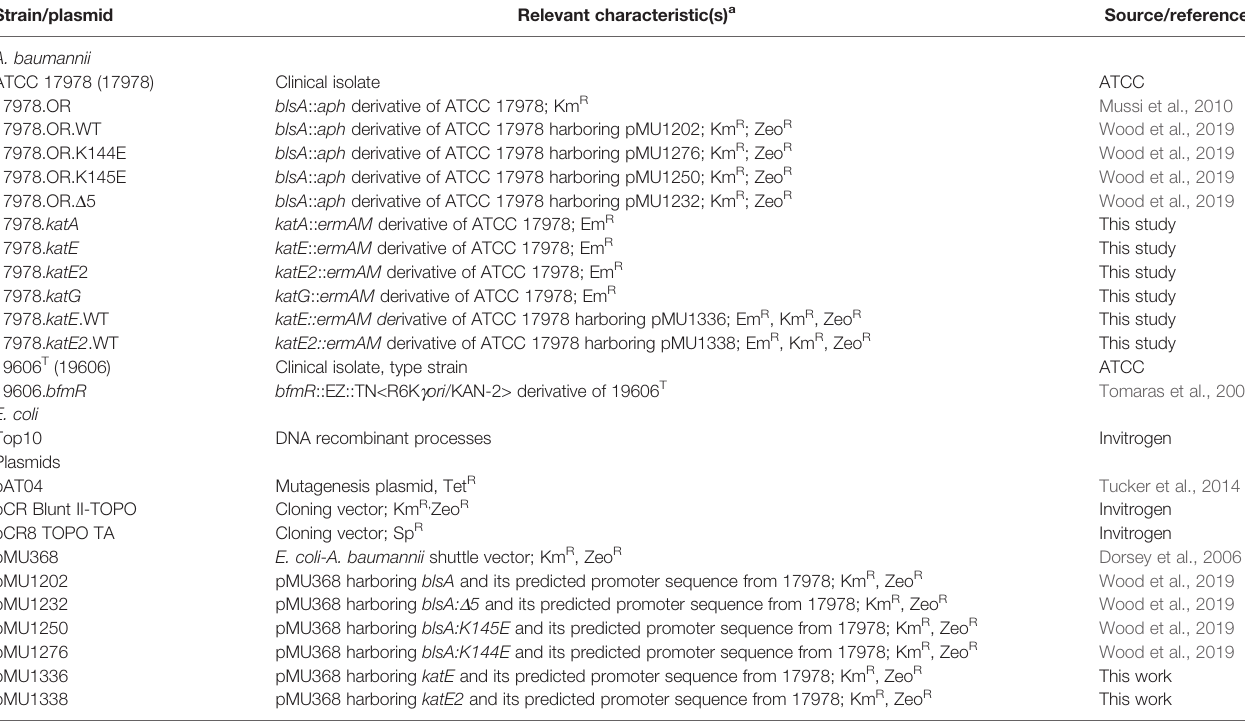
TABLE 1 | Bacterial strains and plasmids used in this